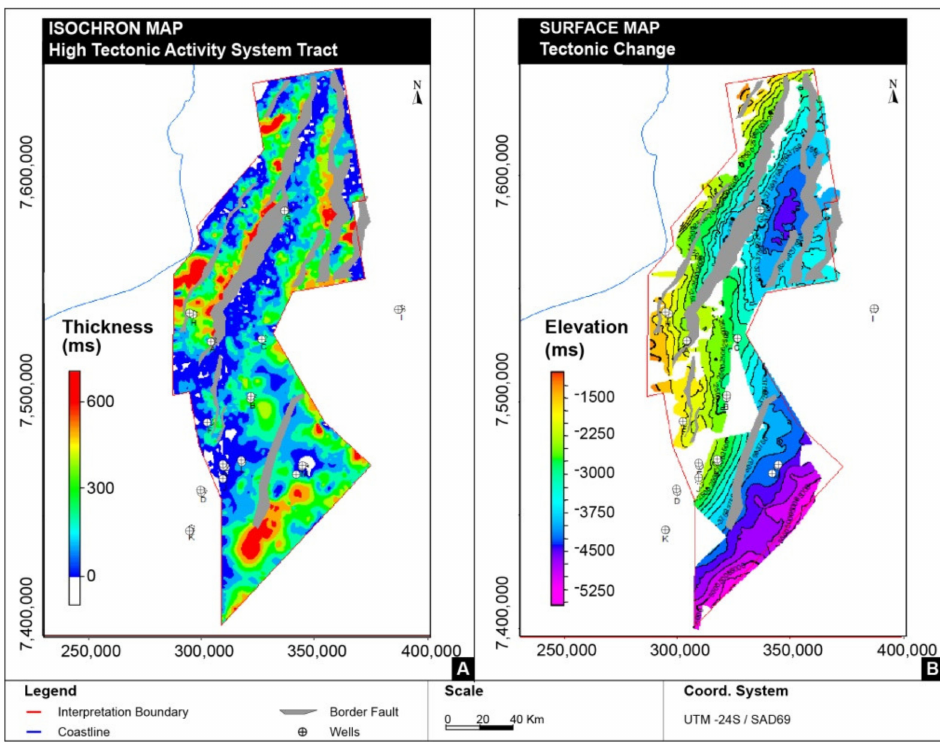
Figure 12. ( A ) ‘Isochronpach’ map (thickness in seismic time) of the HTAST. ( B ) Isochron map (in seismic time) of the tectonic change